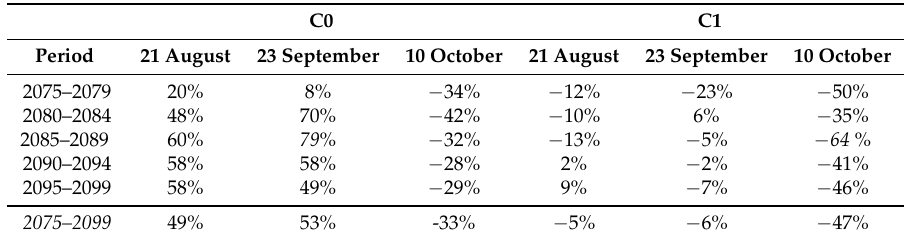
Table 3. Average change in percentage from simulated baseline for 5-year period at the End-of-Century for C0 and C1 SST-Ensembles.